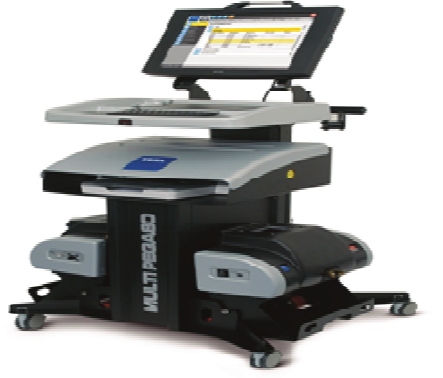
Fig. 7. Gasbox Autopower emission control device [10] Table 2. Gasbox Autopower technical specification